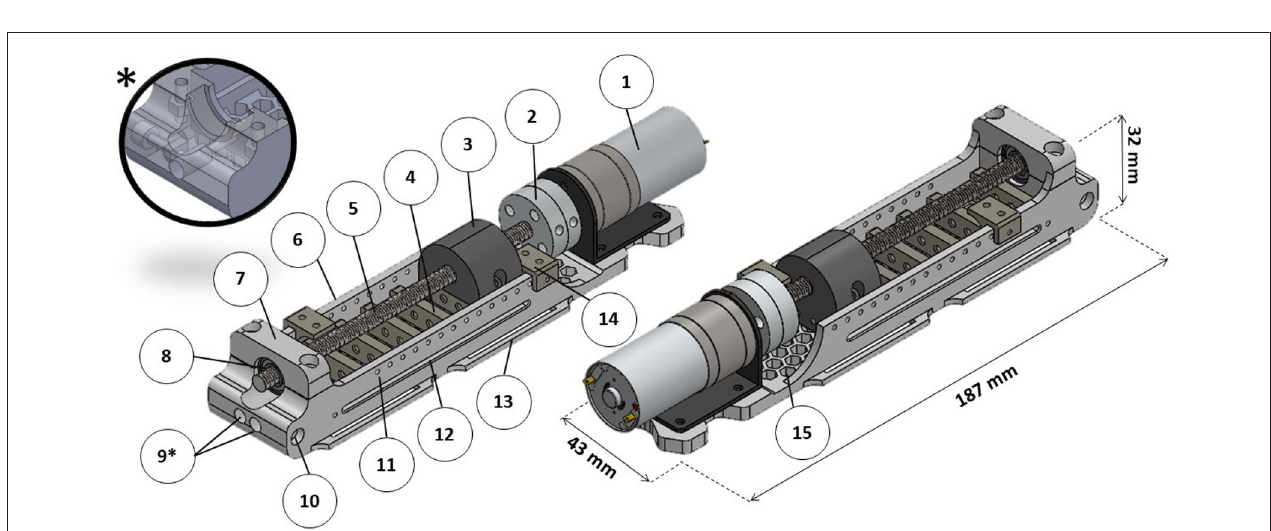
FIGURE 5 | Cable-driven mechanisms. (A) The absence of a mandrel to wrap the cable can cause it to flex under compression. This mechanism is not dimensionally efficient by virtue of its long length. (B) The Concertina mechanism, which consists of six limiters to prevent cables from bending.